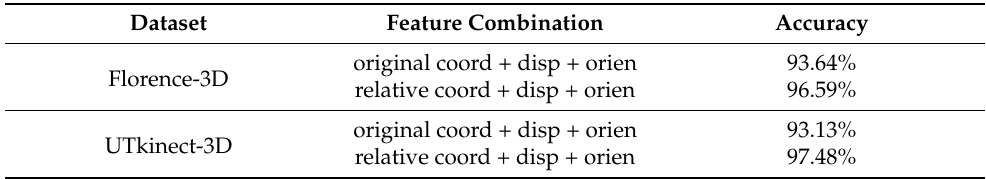
Table 3. Compare the recognition results of original coordinate and relative coordinate combine with other two features separately on two datasets using our network (coord represents coordinate of joints and disp, orien denote the immediate displacement and immediate motion orientation).